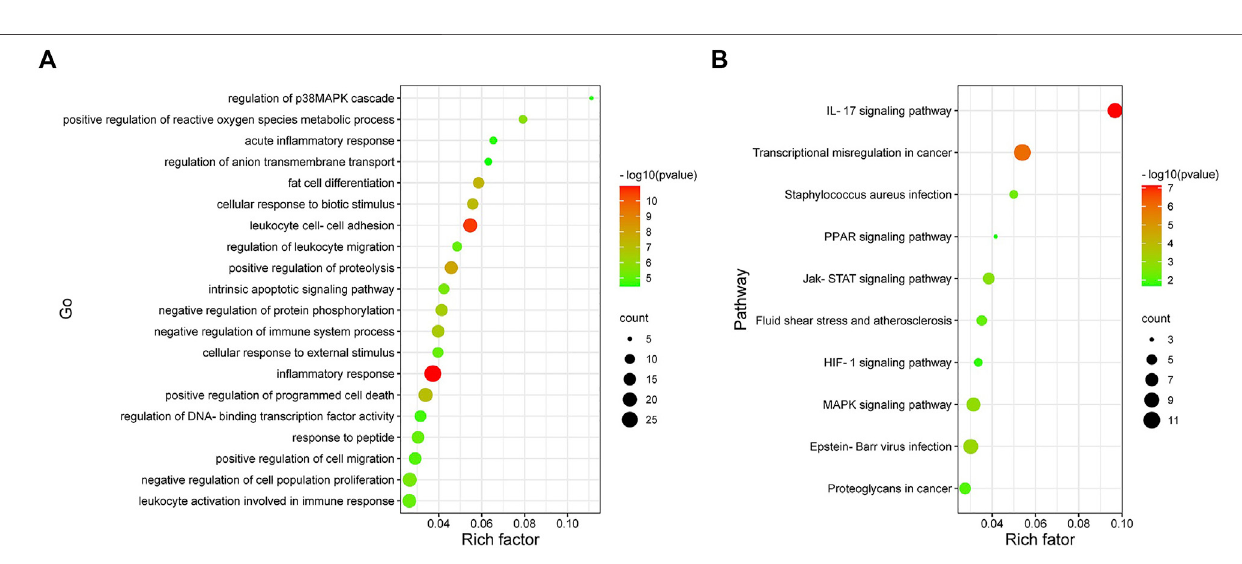
FIGURE5| AnalysisresultsofCo-DEGsintheGeneontology(GO)andKyotoencyclopediaofgenesandgenomespathway(KEGG). (A) ResultsofGOenrichment analysis of Co-DEGs. The color represents the pvalue, and the size of the spots represents the gene number. (B) Results of KEGG pathway analysis of Co-DEGs. The color represents the p -value, and the size of the spots represents the gene